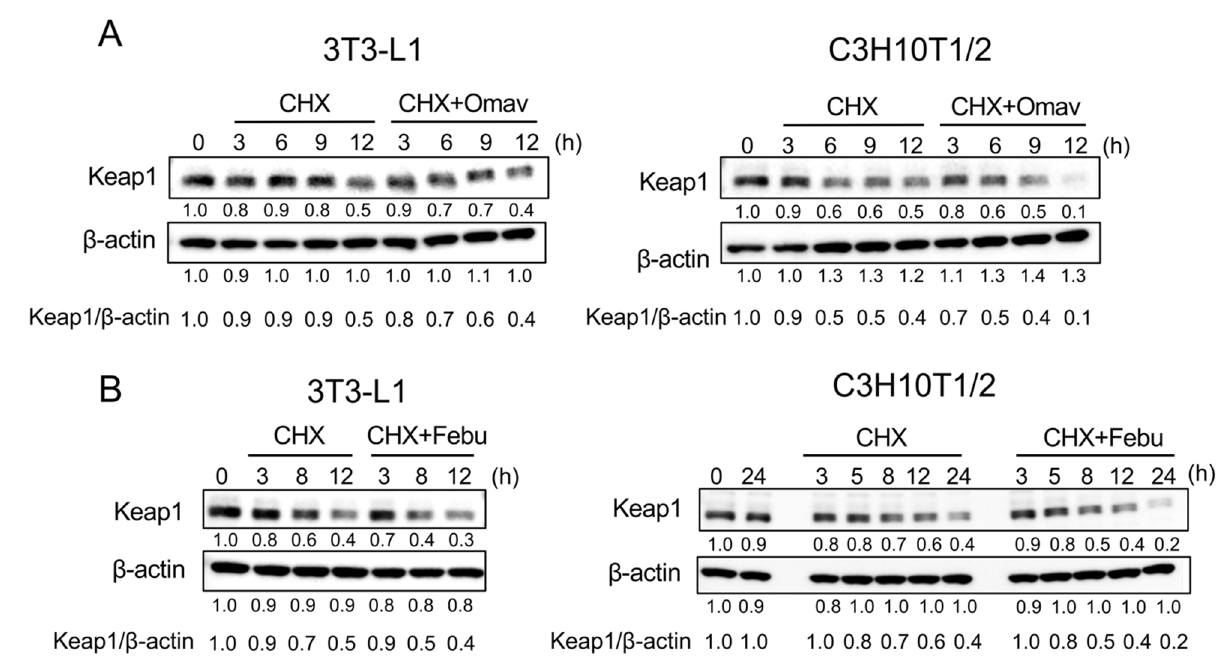
Figure 7. Febuxostat facilitates the degradation of kelch-like ECH-associated protein 1 (Keap1). ( A , B ) 3T3-L1 and C3H10T1/2 cells were cultured in the presence of cycloheximide with or without Omav or Febu for the indicated time period. Keap1 levels were analyzed by western blotting. β -actin served as a loading control. Relative changes in the band intensities normalized by respective loading controls are indicated.